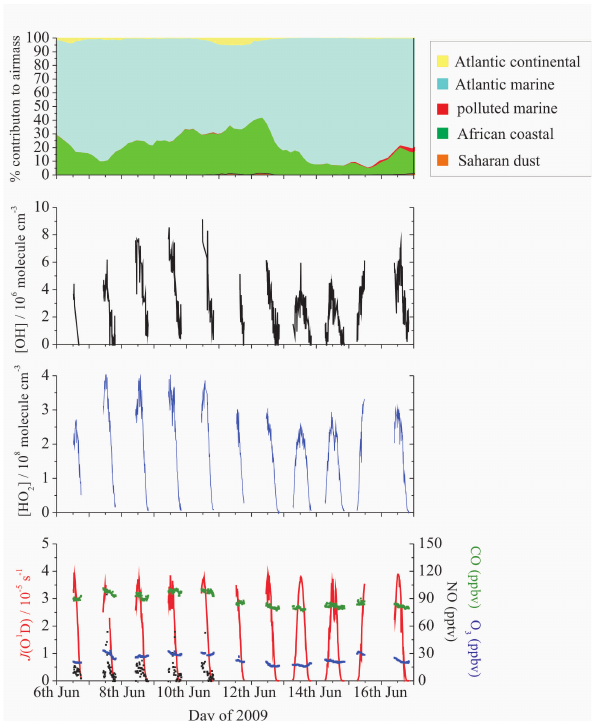
Fig. 4. Time-series of OH, HO 2 and supporting measurements for SOS2. Top panel: source-region percentage contributions to air mass from Atlantic continental (yellow area), Atlantic marine (blue area), polluted marine (red area), African coastal (green area) and Saharan dust (brown area). Middle panels: observed concentrations of OH (five-minute average) and HO 2 (four-minute average). Bot- tom panel: five-minute averaged J (O 1 D) (red line), and the aver- age mixing ratios of CO (green dots), O 3 (blue dots) and NO (black dots); for clarity only the supporting data that are simultaneous with HO x -measurements are